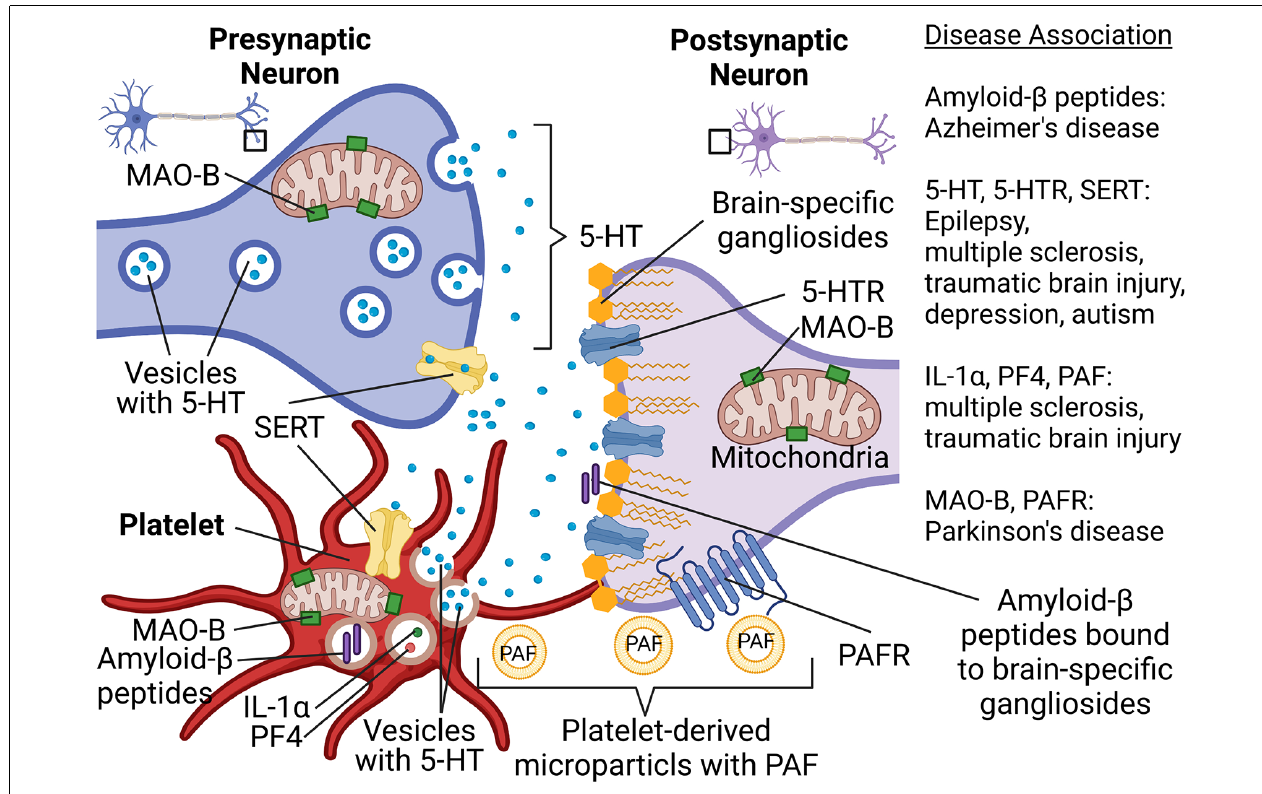
FIGURE 1 | Platelet-neuron similarity and platelet-neuron interactions have implications for a wide range of neuropsychological disorders such as Alzheimer’s disease, Parkinson’s disease, multiple sclerosis, traumatic brain epilepsy, and depression. Abbreviations: 5-HT, Serotonin; 5-HTR, 5-HT receptor; IL-1 α , Interleukin 1 α ; MAO-B, Monoamine oxidase B; PAF, Platelet-activating factor; PAFR, PAF receptor; PF4, Platelet factor-4; SERT, Serotonin transporter. Created in